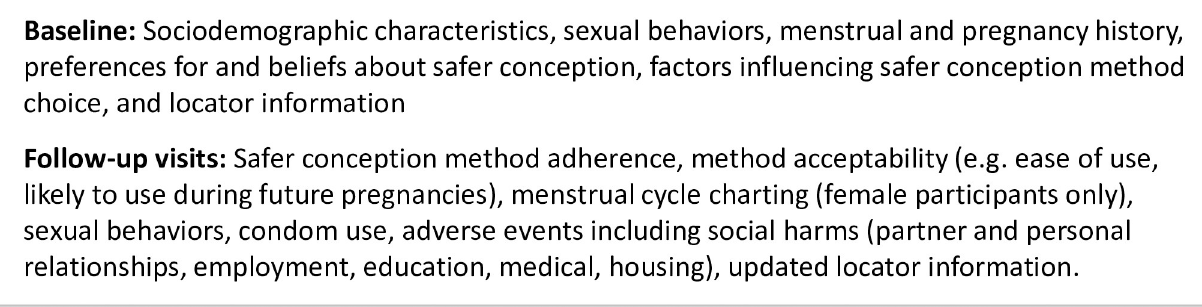
Fig 5. Sociodemographic and behavioral data collected from all couples at baseline and during